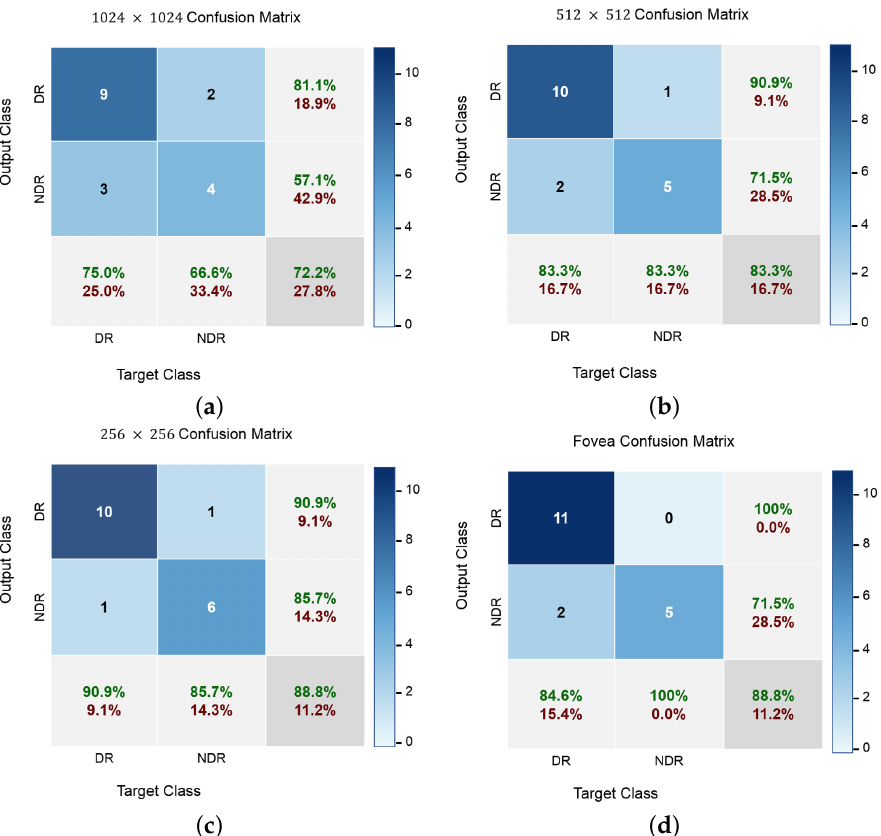
Figure 8. The grading details confusion matrix. The grades DR and NDR respectively correspond to the classes 1 and 2. ( a ) Phase 1: 1025 × 1024; ( b ) Phase 2: 512 × 512; ( c ) Phase 3: 256 × 256; and ( d ) Phase 4: Fovea. Please note that the green and dark-red colored-numbers represent the percentage of correctly and incorrectly classified instances,